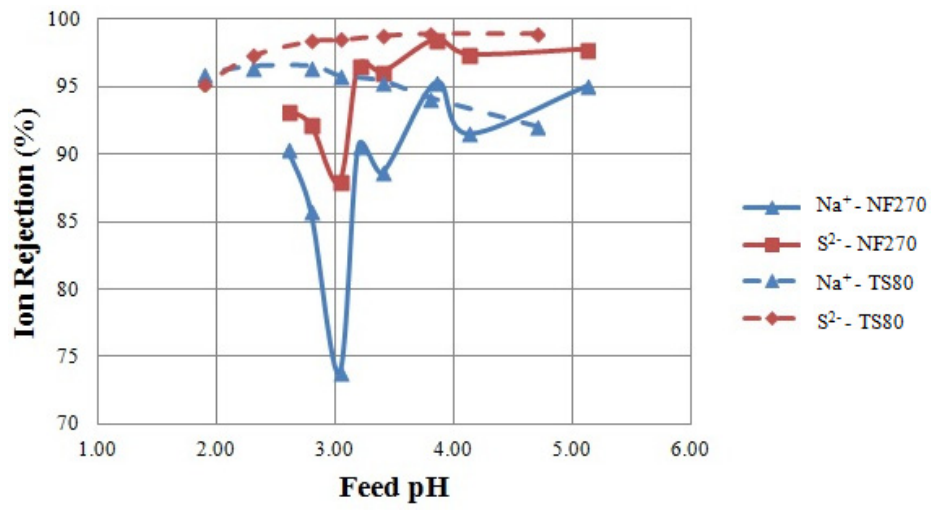
Figure 2. Ion rejection as a result of the IEP Tests. Tested feed solution: sodium chloride and sodium sulphate solutions. Tested membrane: NF 270 and TS